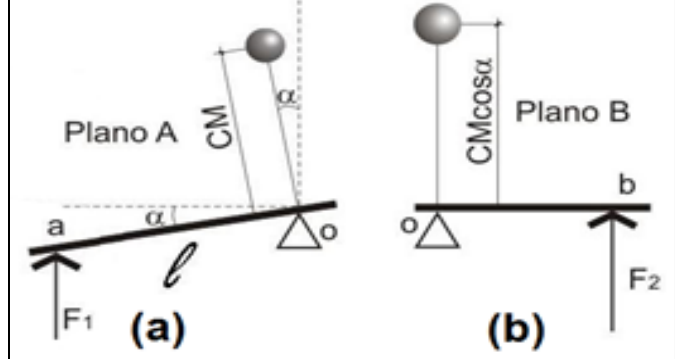
Figura 5: (a) Vista perpendicular al Plano A con ángulo α (b) Vista perpendicular al Plano B con ángulo α. Fuente: Autores, (2015).